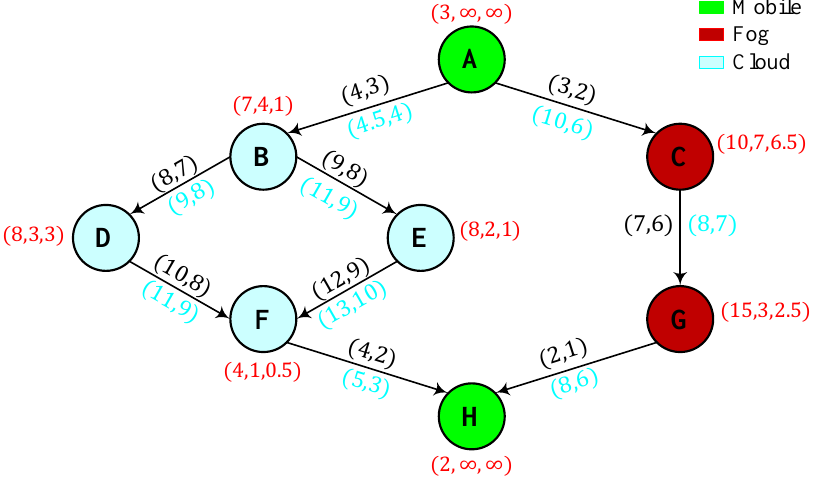
Figure 2. A toy example illustrating the energy-saving capability of multi-tiered Mobile-Fog-Cloud computing platforms that employ both WiFi and Cellular links, in order to connect the computing